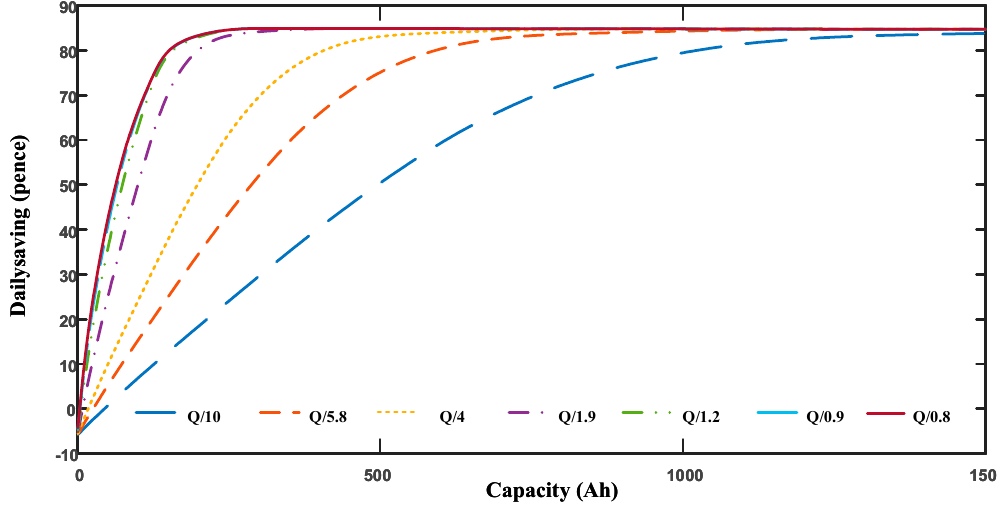
Figure 5. Daily energy cost saving vs. battery capacity at different discharge currents (deep discharge).